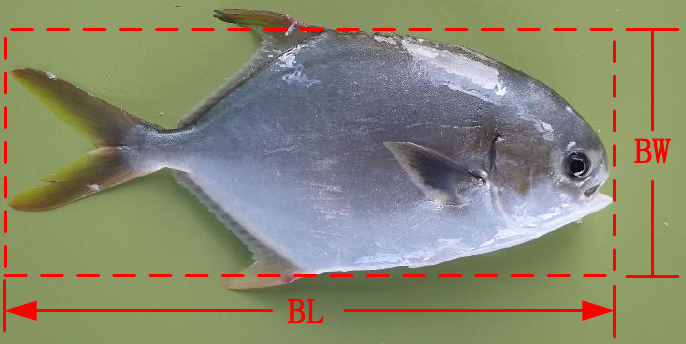
Fig. 6 Measurement standards of fish body length and body width.